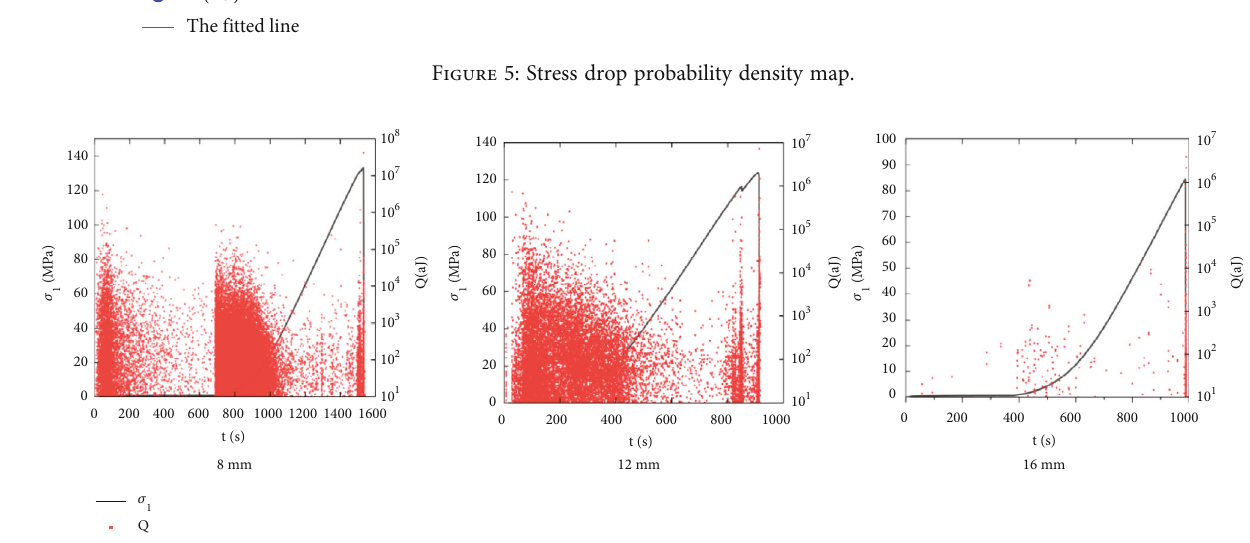
Figure 6: Relationship between acoustic emission energy and stress with